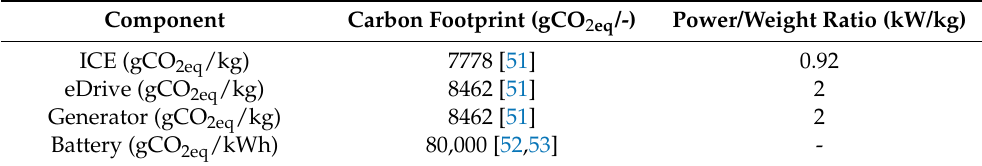
Table 5. Component production carbon footprint impact